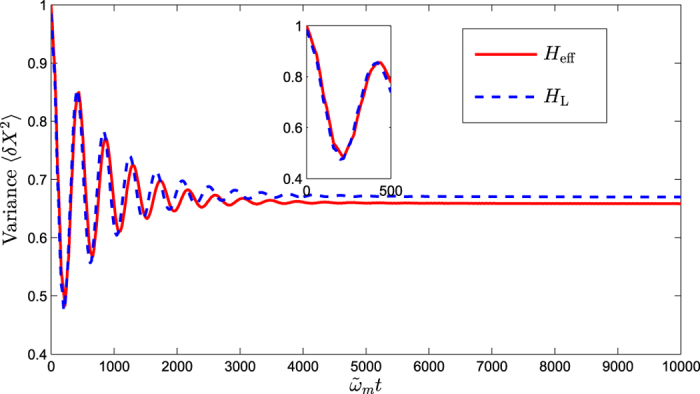
The variance of the displacement quadrature X relates to the time evolution with the Hamiltonian HL and Heff.